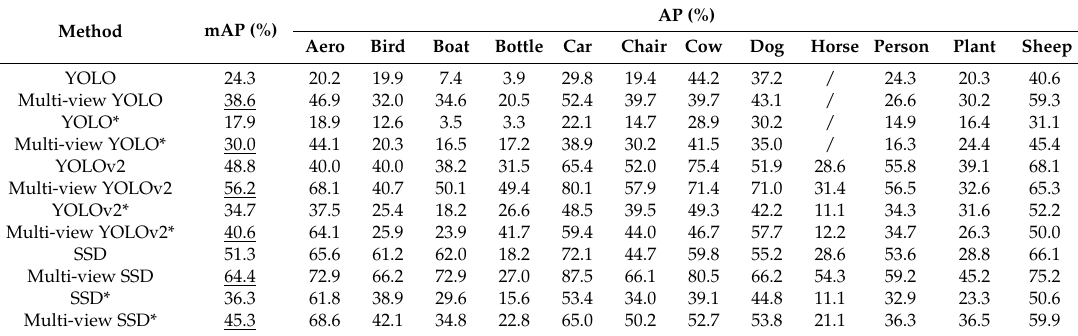
Table 2. Small object detection results for regression-based methods on the VOC 2007 dataset. Method YOLO